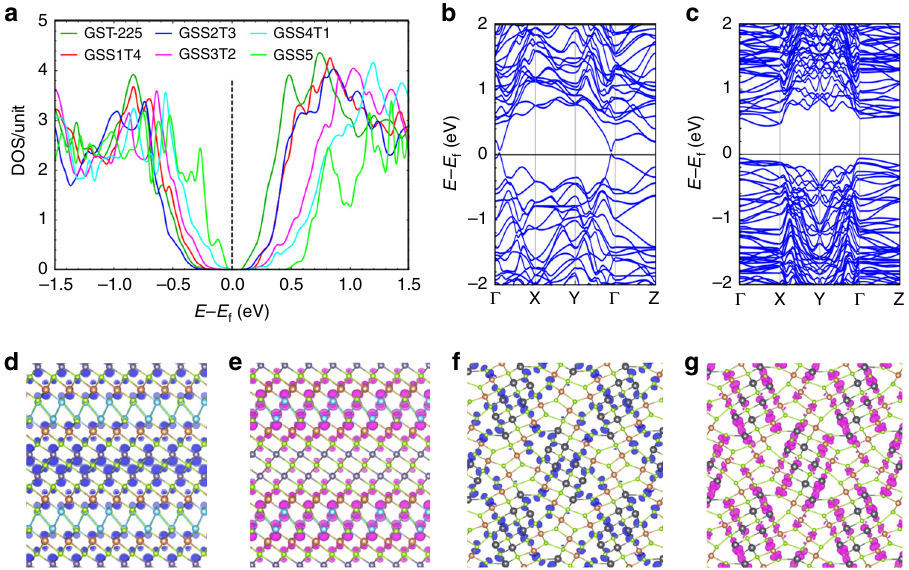
Fig. 2 Comparison of electronic structures of hexagonal and orthorhombic phases. a DOS of hexagonal Ge – Sb – Se – Te and orthorhombic Ge 2 Sb 2 Se 5 , with the Fermi level illustrated by the dashed line. Band structures of b hexagonal Ge 2 Sb 2 Se 4 Te 1 (GSS4T1); and c orthorhombic Ge 2 Sb 2 Se 5 . Charge densities of d , f valence band maximum (VBM) in blue and e , g conduction band minimum (CBM) in magenta of d , e hexagonal GSS4T1 and f , g orthorhombic Ge 2 Sb 2 Se Fig. 7 in Supplementary Note 3 present X-ray diffraction (XRD) increasing Se substitution. On the other hand, Ge 2 Sb 2 Se 5 undergoes a sluggish growth-dominated transformation into an spectra of the fi lms annealed at different temperatures. All as- orthorhombic equilibrium phase con fi rmed with selected area deposited fi lms are amorphous. For fi lms with x = 0 – 4, annealing electron diffraction (SAED) measurement (Supplementary induces a nucleation-dominated phase change where the fi lms fi rst crystallize into a metastable phase followed by complete Note 4). These fi ndings are in excellent agreement with our theoretical predictions. The DFT modeled structures are further transition to the stable hexagonal structure. The crystallization corroborated by quantitative fi tting of the XRD spectra. For onset temperature progressively increases with Se substitution, instance, DFT predicts lattice constants of a = 4.04 Å and c = signaling enhanced amorphous phase stability. The intermediate 16.08 Å for hexagonal GSS4T1 whereas XRD fi tting yields temperature regime for the metastable phase also diminishes with